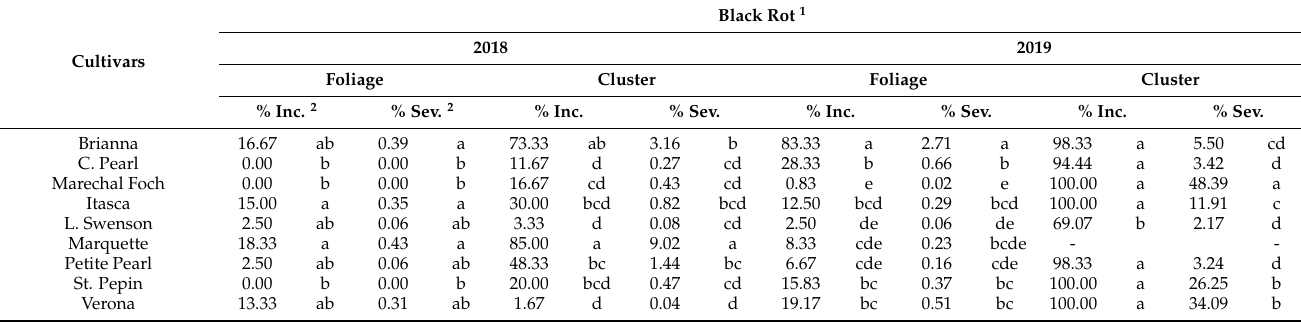
Table 3. Comparison of the incidence percentage and severity of black rot symptoms on grape foliage and clusters in 2018 and